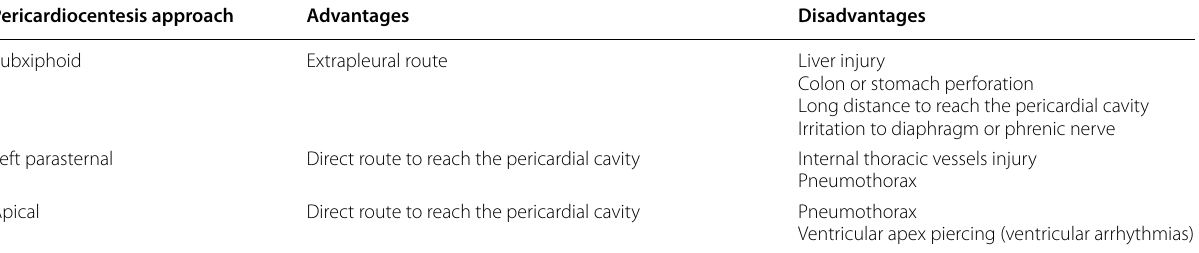
Table 2 Advantages and disadvantages of pericardiocentesis approaches (modified from